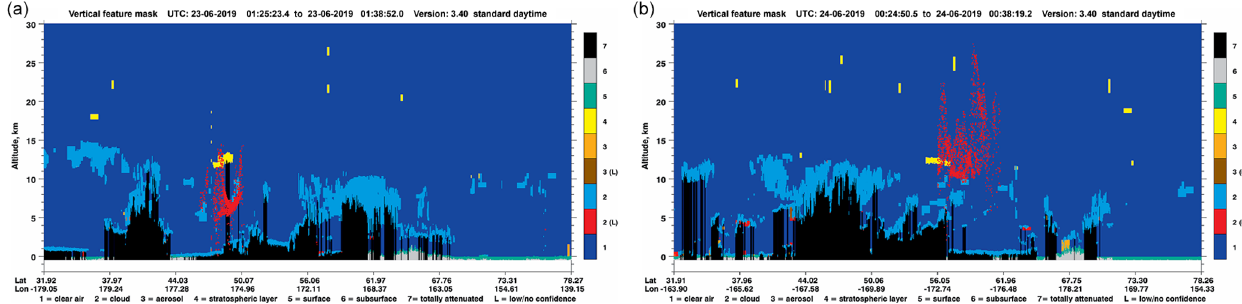
Figure 16. CALIOP/CALIPSO vertical feature mask for the measurements of the Raikoke plume on 23 June 2019 at around 01:30UTC (a) and on 24 June 2019 at around 00:30UTC (b) . Red dots show the retrieved FP_ILM SO 2 LH for pixels with SO 2 VCDs greater than or equal to 20DU. The ground track of the CALIPSO measurements is shown in Fig. 14. Note that the classification scheme sometimes cannot pick up the volcanic ash or sulfate aerosol because of competing clouds. CALIPSO image credit: